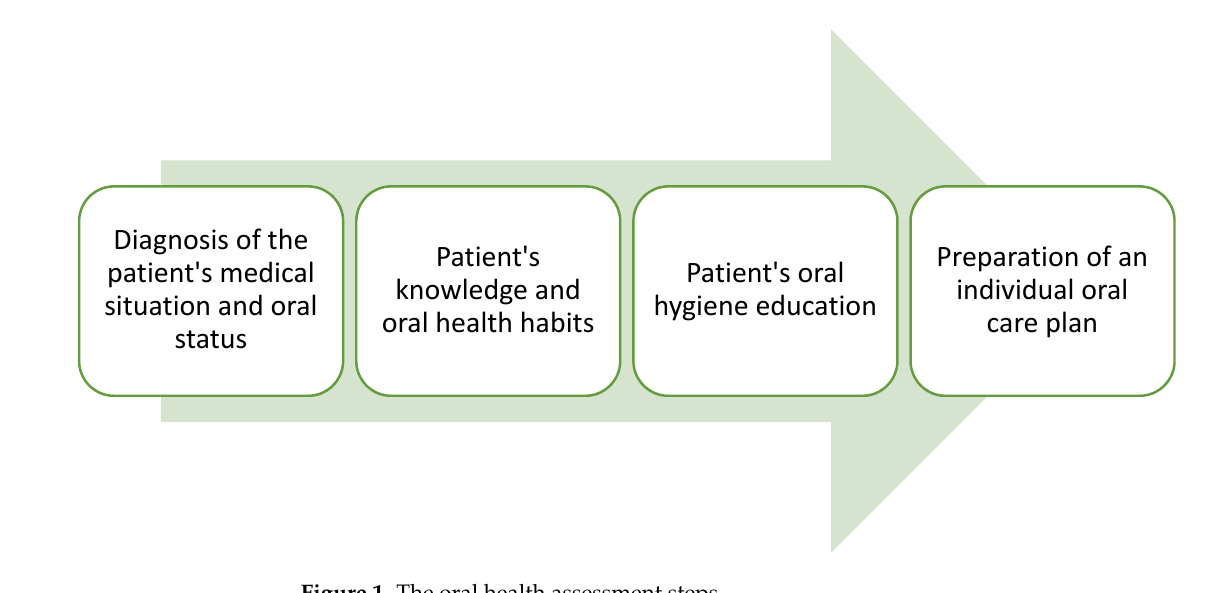
Figure 1. The oral health assessment steps. Table 3. Elements of a comprehensive oral assessment in a nursing care plan.